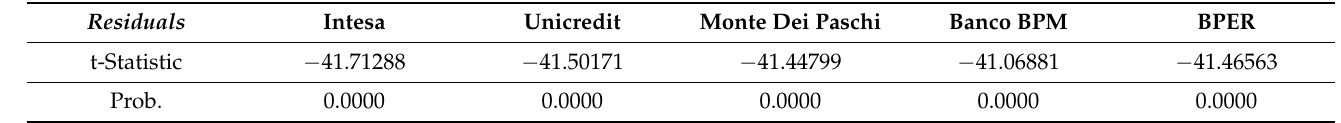
Table 2. Augmented Dickey–Fuller Test: period of January 2015–December 2021.